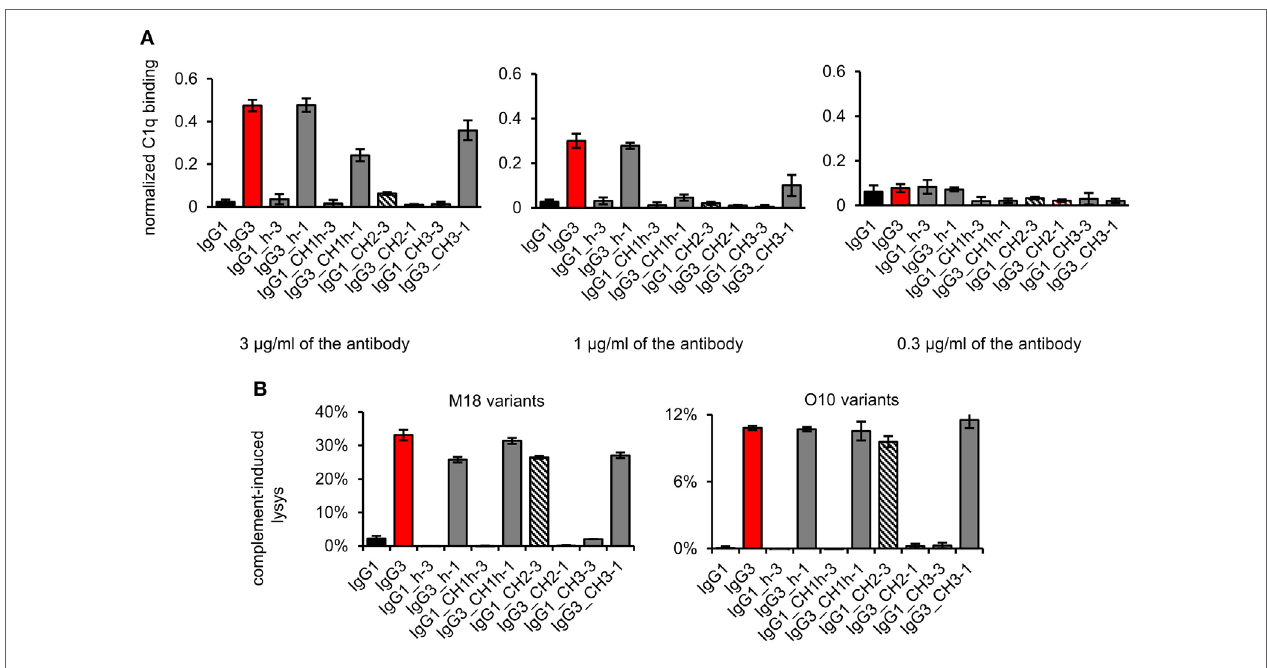
FigUre 6 | Complement activation induced by the domain muteins. (a) C1q binding to the domain muteins (O10 variants). The data used for calculations are presented in Figure S7 in Supplementary Material. Error bars correspond to uncertainty calculated as described in Section “Materials and Methods.” (B) Complement cascade activation by the domain muteins. Erythrocytes coated with 3 µg/ml of the muteins were incubated with complement serum. 100% lysis corresponds to water-induced lysis. The bars present mean values and standard deviation of duplicates from one experiment. Results obtained with 1.5 µg/ml of the muteins are presented in Figure S8 in Supplementary Material. (a,B) Representative results of two independent